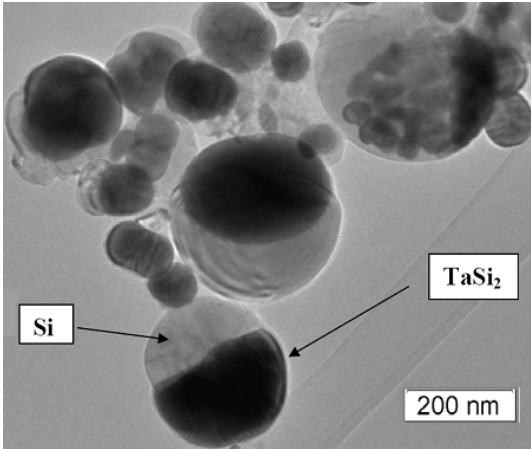
Figure 2. Transmission electron microscopy (TEM) image of the obtained TaSi 2 /Si